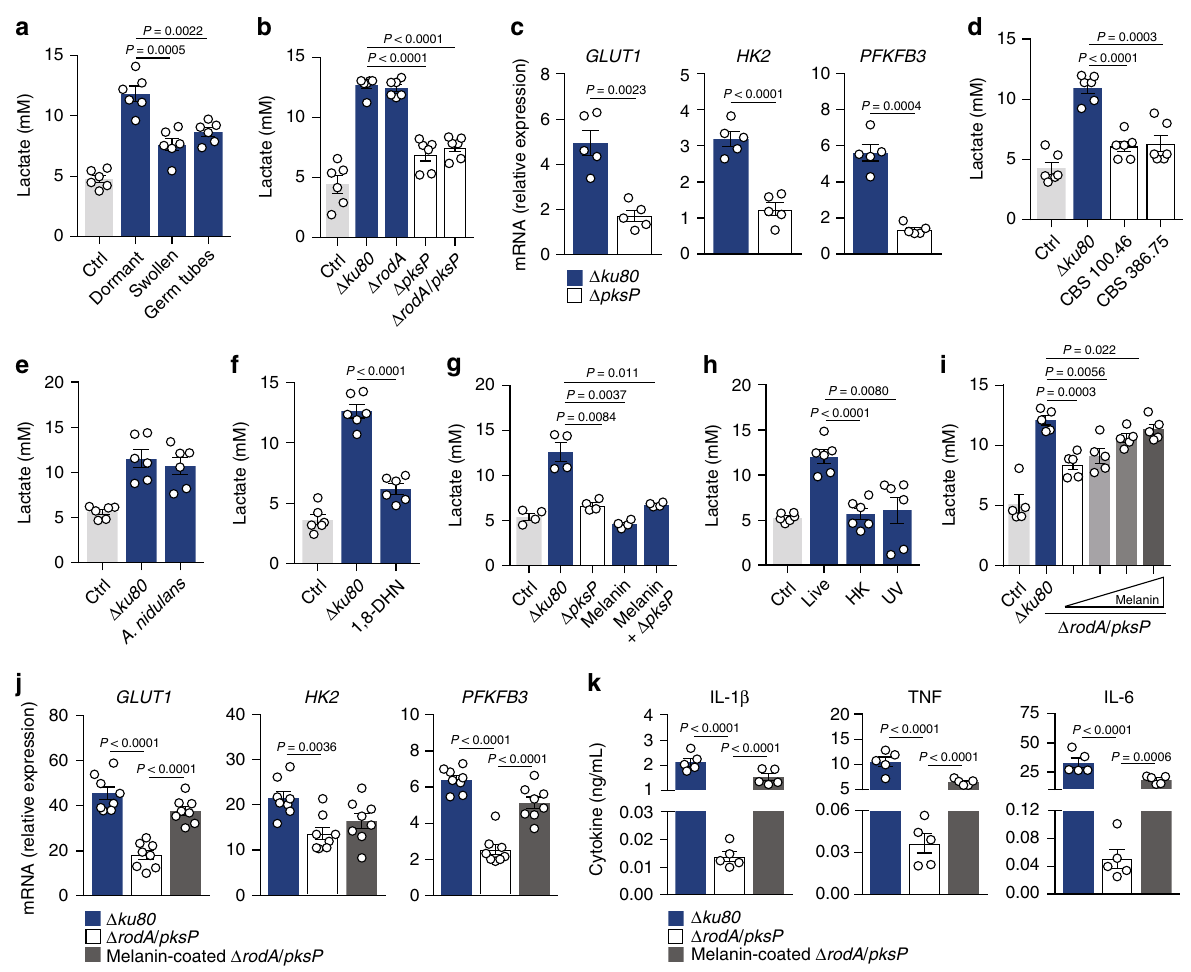
Fig. 3 Intracellular removal of fungal melanin induces glucose metabolism. a Lactate secretion by macrophages left untreated (Ctrl) or infected with dormant or swollen conidia, or germ tubes of A. fumigatus for 24 h ( n = 6). b Lactate secretion by macrophages left untreated (Ctrl) or infected with dormant conidia from the parental Δ ku80 strain or the cell wall mutants Δ rodA , Δ pksP , or Δ rodA/pksP for 24 h ( n = 6). c mRNA expression of GLUT1 , HK2 , and PFKFB3 in macrophages infected with Δ ku80 or Δ pksP strains for 2 h relative to uninfected cells ( n = 5). d Lactate secretion by macrophages left untreated (Ctrl) or infected with the albino CBS 100.46 and 386.75 strains of A. fumigatus ( n = 6), e the WG355 strain of A. nidulans ( n = 6), f 1,8-DHN ( n = 6), or g the Δ pksP strain, DHN – melanin, or DHN – melanin added together with Δ pksP conidia ( n = 4) for 24 h. Infection with Δ ku80 conidia was used as control. h Lactate secretion by macrophages left untreated (Ctrl) or infected with live, heat-killed (HK), or UV-inactivated (UV) conidia for 24 h ( n = 5). i Lactate secretion by macrophages infected with the Δ ku80 , Δ rodA/pksP , or the Δ rodA/pksP strain coated with 100, 300, and 600 µ g/mL of DHN – melanin for 24 h ( n = 5). j mRNA expression of GLUT1 , HK2 , and PFKFB3 ( n = 8) and k production of IL-1 β , TNF, and IL-6 ( n = 5) by macrophages infected with the Δ ku80 , Δ rodA/pksP , or the melanin-coated Δ rodA/pksP strain for 2 or 24 h, respectively, relative to uninfected cells ( n = 8). Data are expressed as mean values ± SEM. P -values were calculated using Student ’ s two-tailed t test or one-way ANOVA with Tukey ’ s multiple comparisons